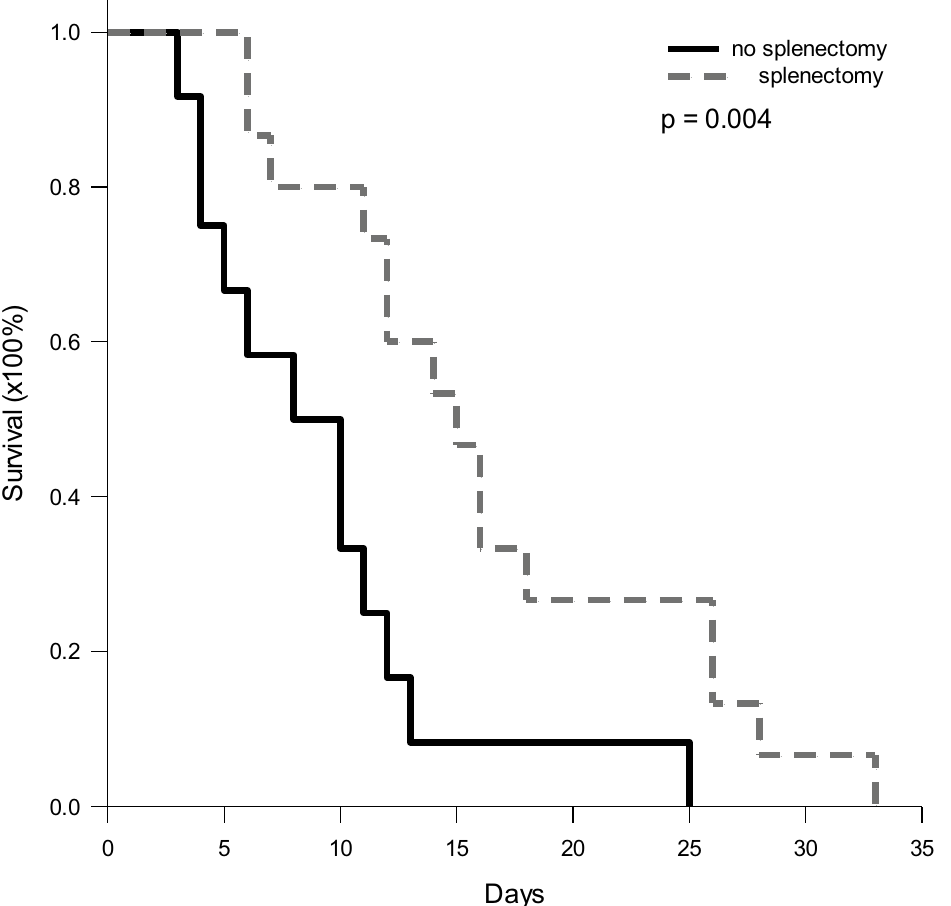
Figure 8. Survival rate of mice bearing Hepa1-6 tumors after splenectomy. Twelve tumor-bearing mice received a splenectomy. Their survival was significantly prolonged compared to that of mice without splenectomy (16.4 ± 8.36 versus 9.25 ± 6.02 days, p =